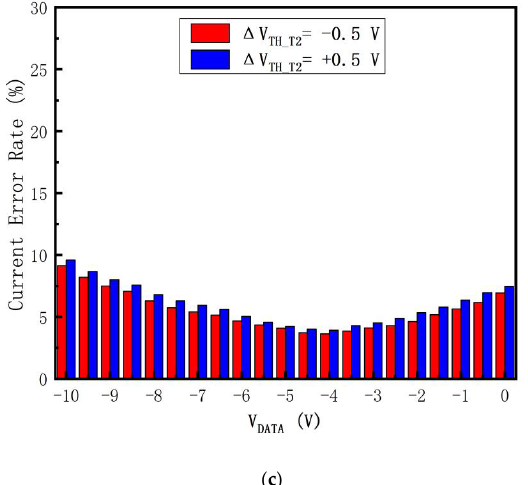
Figure 5. Transient waveforms of ( a ) V B and ( b ) I OLED when Δ V TH_T2 = −0.5, 0, and +0.5 V at V DATA = −4 V, where (1) initialization stage, (2) threshold voltage extraction stage, (3) data input stage, (4) emission stage, and ( c ) current error rates versus V DATA when the threshold voltage varies. The CER for Δ V TH_T2 is defined as